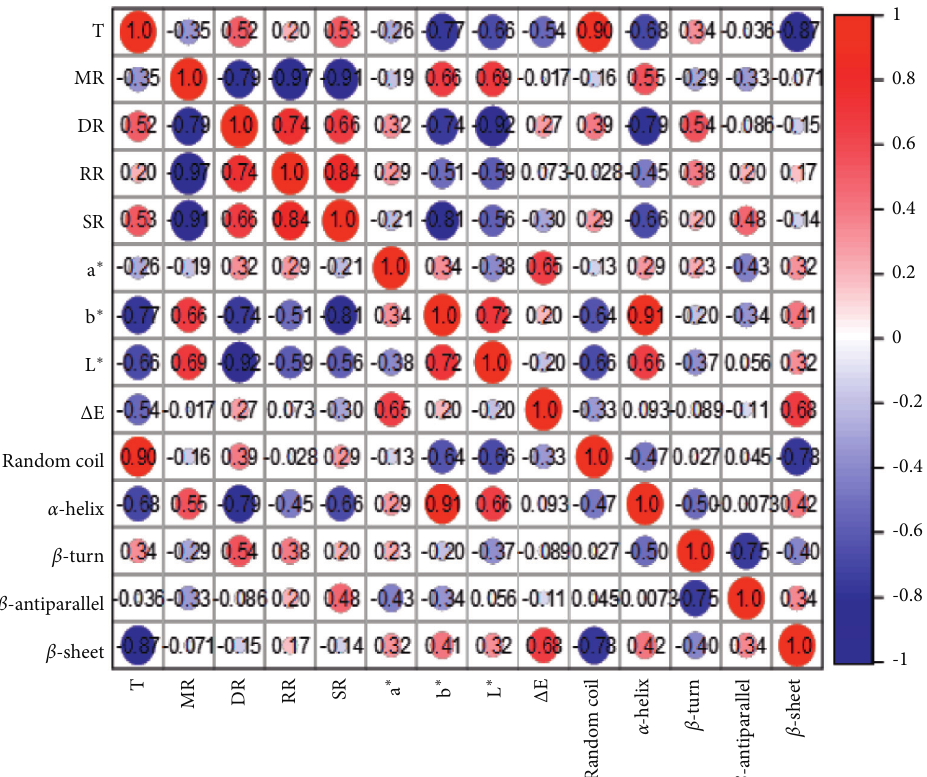
Figure 11: Pearson’s correlation coefficient matrix. T , drying time; RR, rehydration rate; SR, shrinkage